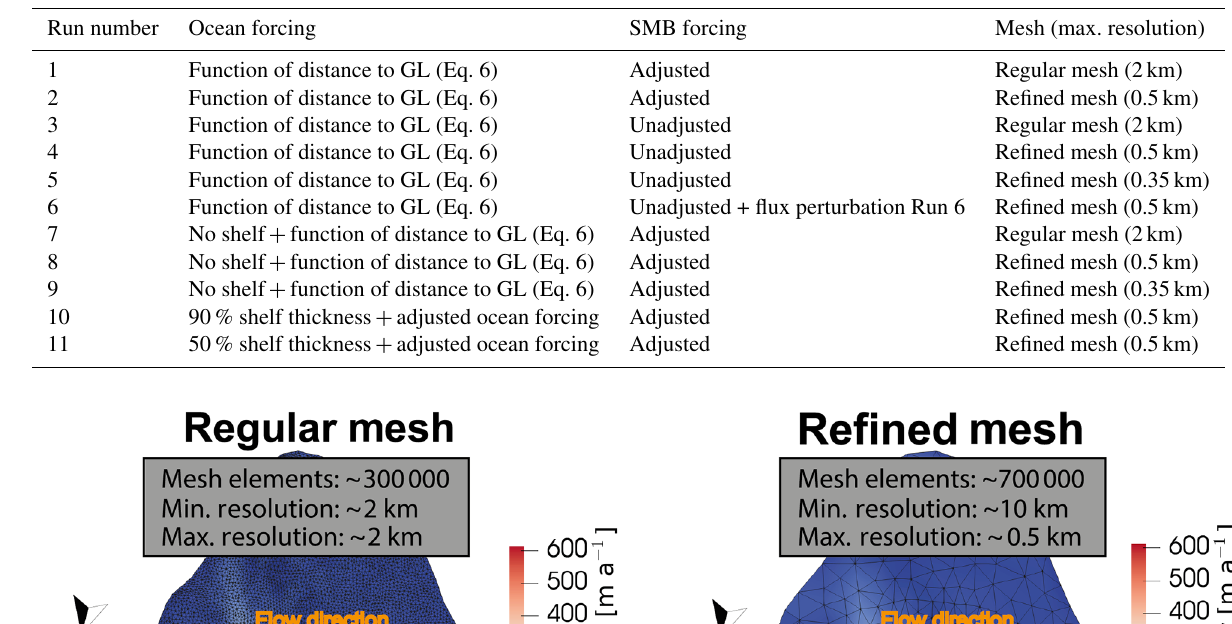
Table 2. List of all perturbation experiments including forcings and mesh resolution.